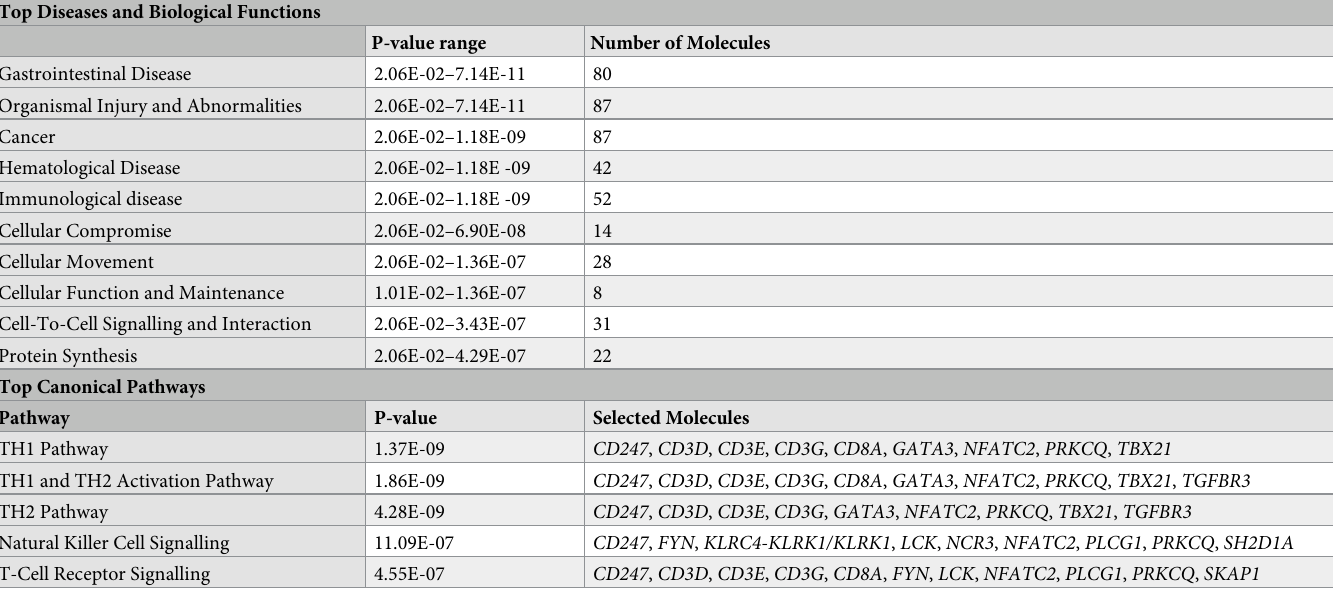
Table 19. Enrichment analysis of genes in smCCA component 1.